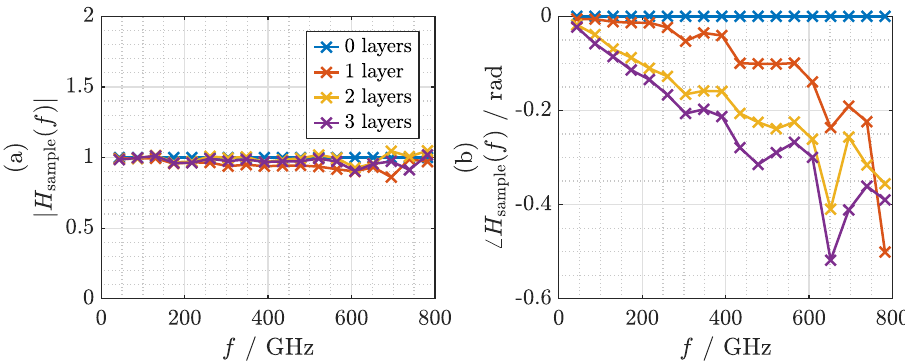
Figure 11. Processed measurement results for 0–3 layers of cling film. ( a ) Magnitude of the transfer function. ( b ) Phase of the transfer function.